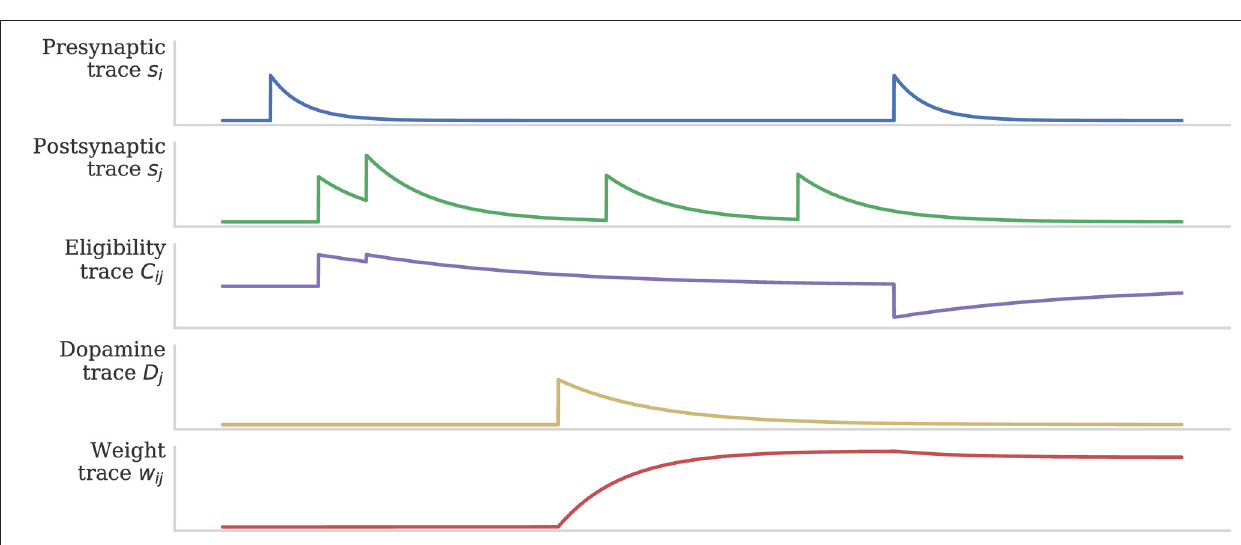
this potentiation would instead be applied to the eligibility